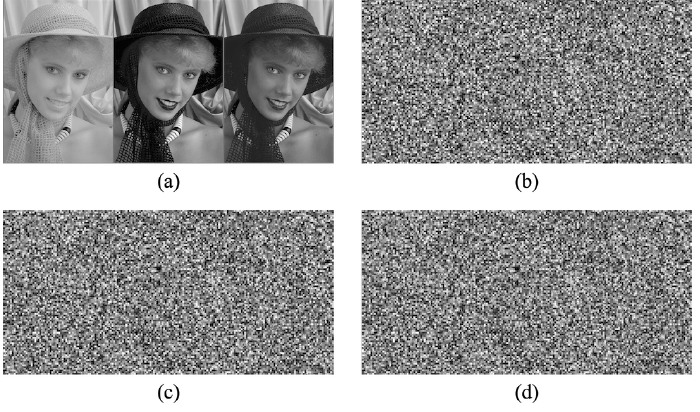
Figure 9. Marked encrypted images (Kodim4). ( a ) Grayscale-based image; ( b ) L = 1, ( c ) L = 3; ( d ) L = 10.